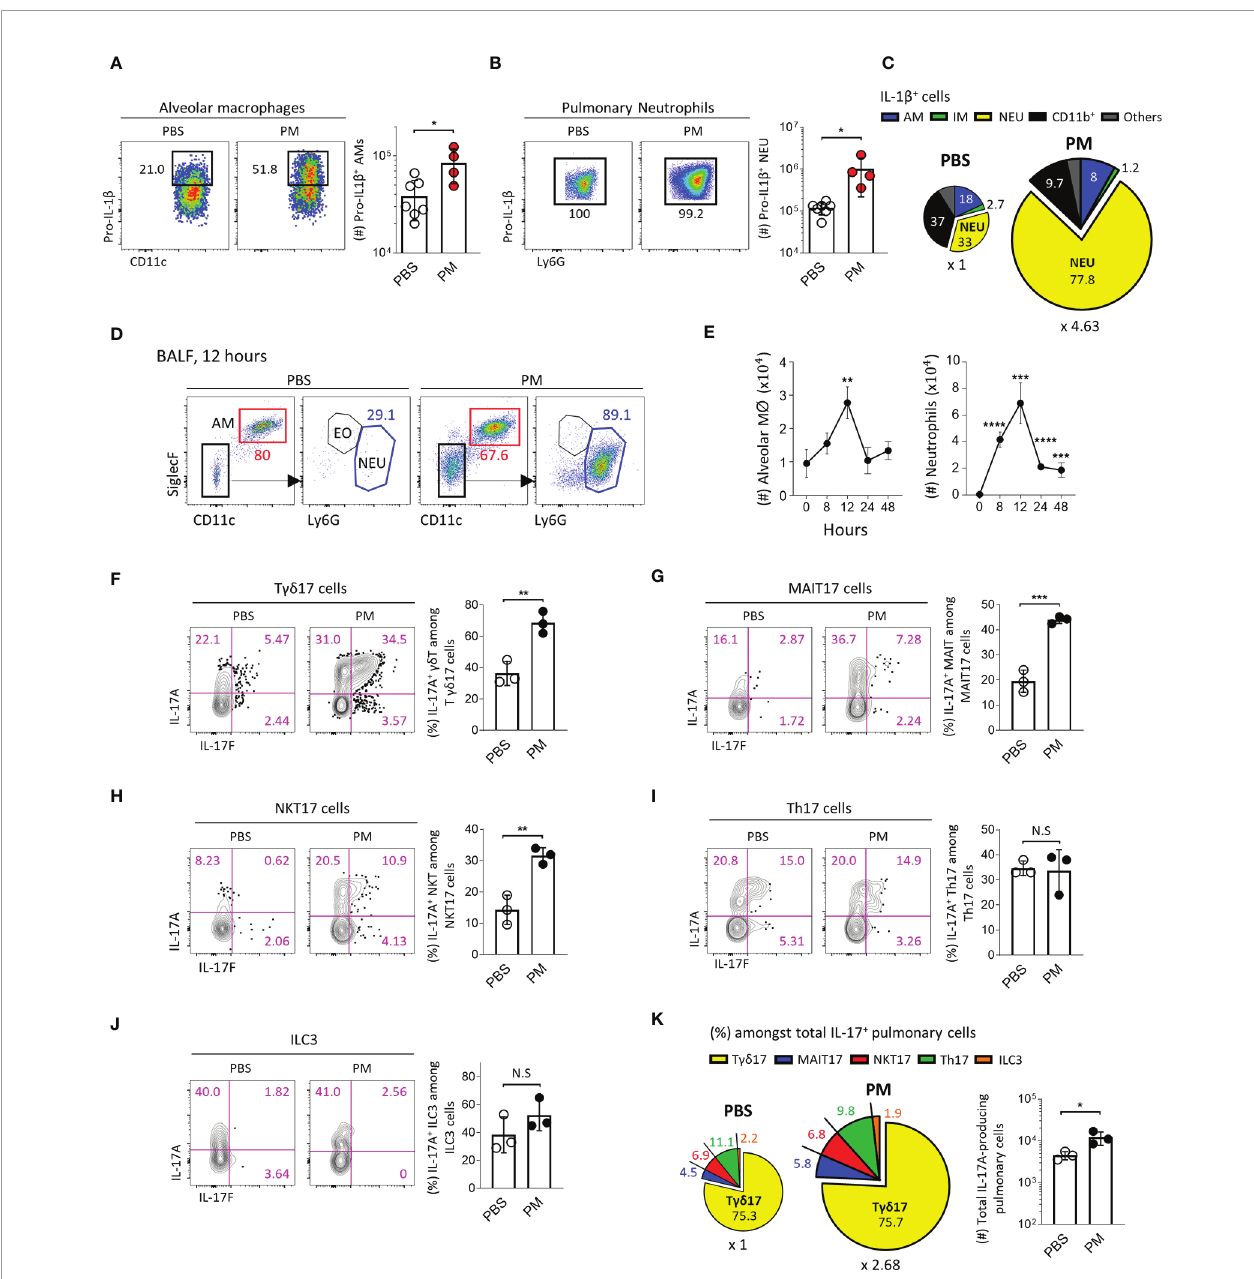
FIGURE 5 | PM induces IL-1 b secretion and acute neutrophilia via T gd 17 cells. (A – C) B6 mice were intranasally administered with 250 m g of PM or PBS and single cell suspensions of lung tissue were analyzed at 4 hours after PM exposure. (A, B) Representative dot plots show alveolar macrophages (A) and neutrophils (B) . Bar graphs show statistical analysis of absolute number of pro-IL-1 b -producing cells. (C) Pie charts show mean frequencies (proportional to angle) and numbers (proportional to area) of indicated cells among total pro-IL-1 b -producing cells. (D, E) B6 mice were intranasally administered with 250 m g of PM and analyzed at indicated time points. (D) Representative dot plots show alveolar macrophages (AM), neutrophils (NEU) and eosinophils (EO) in broncho-alveolar lavage fl uid (BALF) harvested at 12 hours after PM administration. (E) Graphs show the numbers of alveolar macrophages and neutrophils at indicated time periods in BALF (N = 2 ~ 4). (F – K) B6 mice were intranasally administered with 250 m g of PM and mononuclear cells of lung tissue were analyzed at 24 hours after PM exposure. Representative contour plots show IL-17A + or IL-17F + pulmonary T gd 17 (F) MAIT17 (G) NKT17 (H) Th17 (I) and ILC3 cells (J) . Bar graph shows statistical analysis of frequencies of IL-17A-producing cells. (K) Pie charts show mean frequencies (proportional to angle) and numbers (proportional to area) of indicated cells among total IL-17A- producing pulmonary CD45 + cells. Numbers indicate frequencies of cells in adjacent gates or frequencies in each area (C, K) . Each dot represents an individual mouse and error bars indicate ± SD. Unpaired two-tailed t -test was used. N.S, not signi fi cant, *P <0.05, **P < 0.01, ***P < 0.001, ****P < 0.0001. AM, alveolar macrophage; IM, interstitial macrophage; NEU, neutrophils; EO,